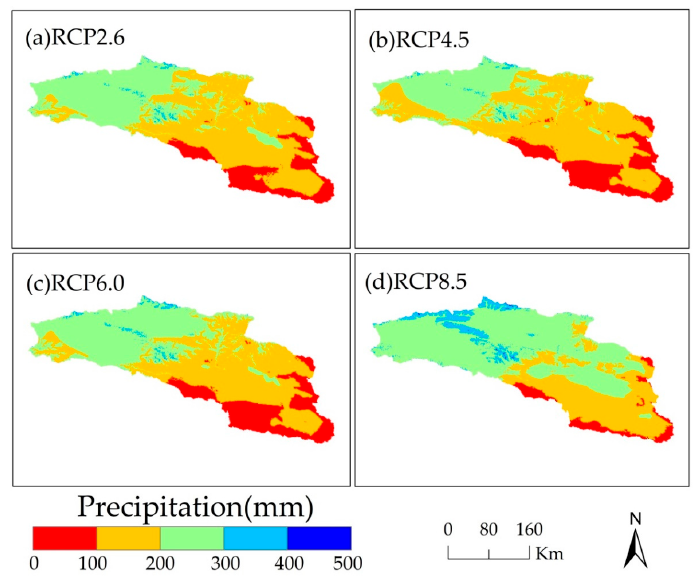
Figure 5. The spatial distribution of annual average precipitation of Bosten Lake basin for RCP scenarios in 2050.